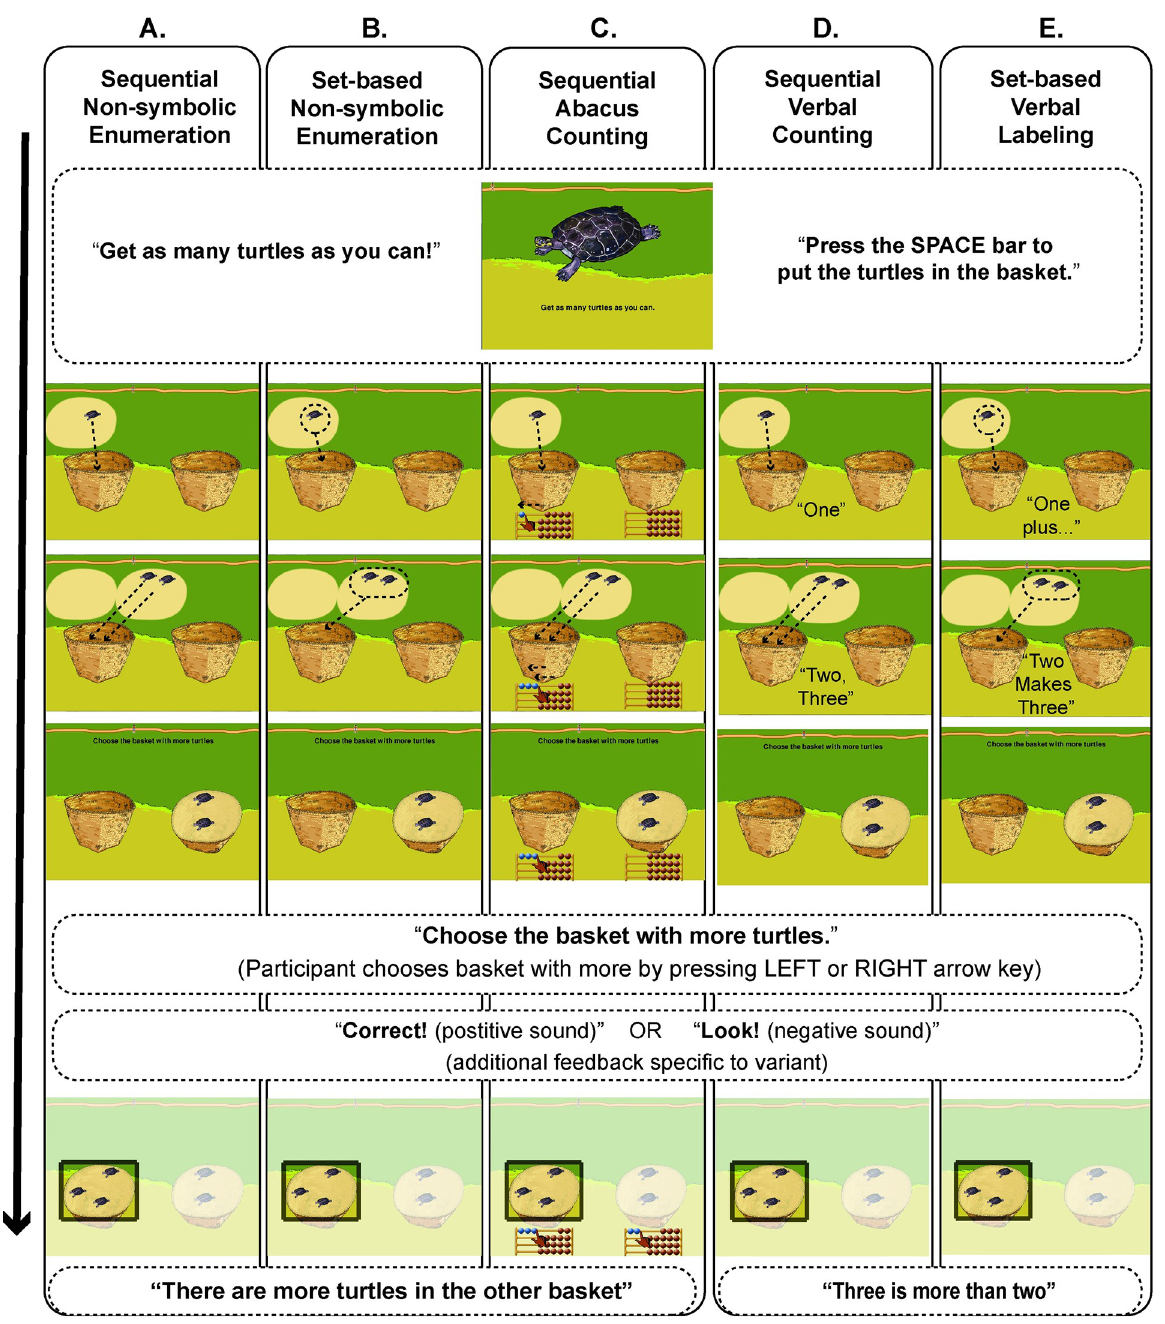
Fig 1. Schematic depiction of the basic training gameplay for the five training variants. Each column illustrates an example trial for each variant (A-E) where the child is asked to track a “1+2” event in the leftmost basket, and then to compare the sum (3) to the set of 2 items in the rightmost basket. Gameplay progresses from top to bottom (solid arrow). Dotted arrows indicate the animations of objects into the baskets, which could be sequential for each object (columns A, C and D) or simultaneous within each circled set of objects (columns B and E). Both the animation and the feedback period could be accompanied by verbal counting (column D) or numerical labeling (column E), or by a symbolic abacus where items moved in one-to-one correspondence with each added object (column C). Note the minimal differences between conditions and overlapping rows that indicate commonalities across the variants. Additional details of gameplay and feedback can be found in the text.